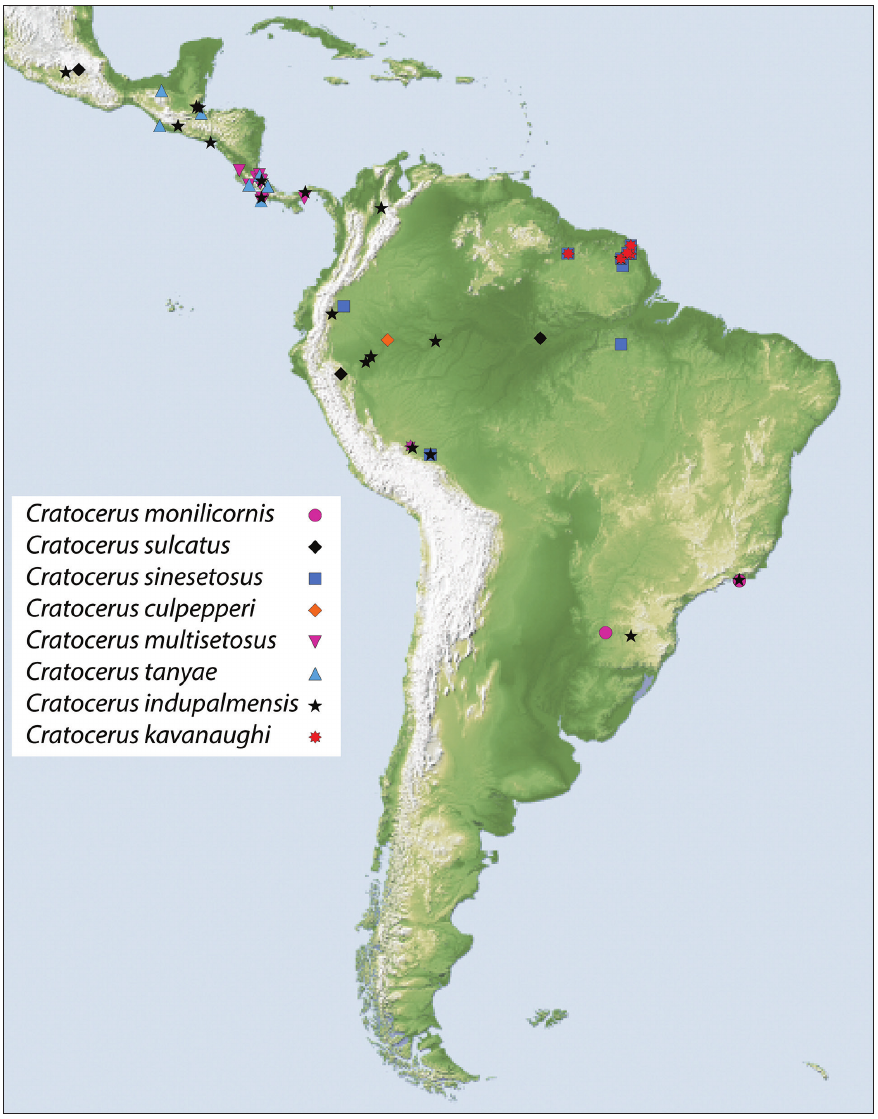
Figure 13. Map showing location of material examined for species of Cratocerus